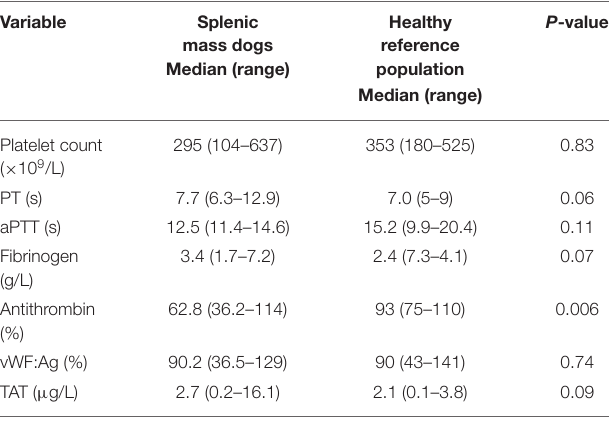
TABLE 1 | Pre-operative hemostatic parameters in dogs with splenic masses compared to the healthy reference population.